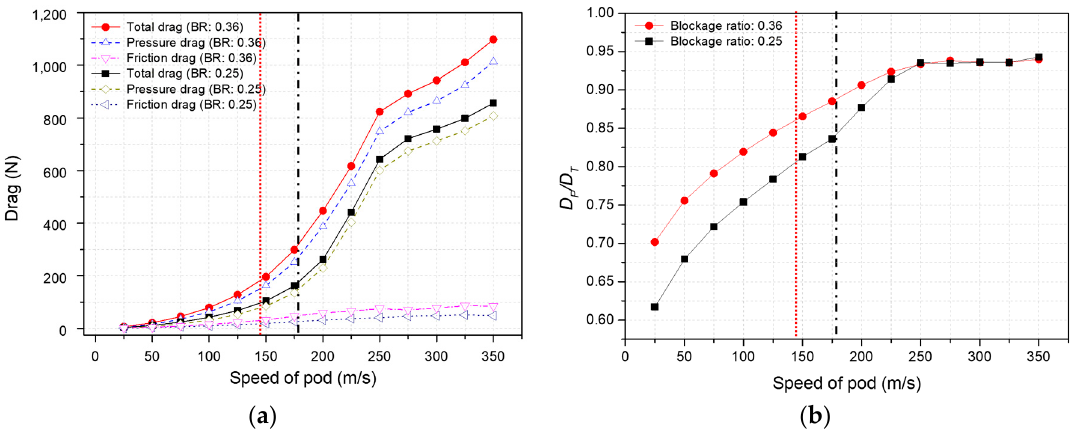
Figure 5. Effects of BR and pod speed on drag. Red dotted and black dot-dashed vertical lines denote the critical Mach number for BR = 0.36 and 0.25, respectively. ( a ) Total, pressure, and friction drag for BR = 0.36 and 0.25 and ( b ) ratio of total drag to pressure drag.